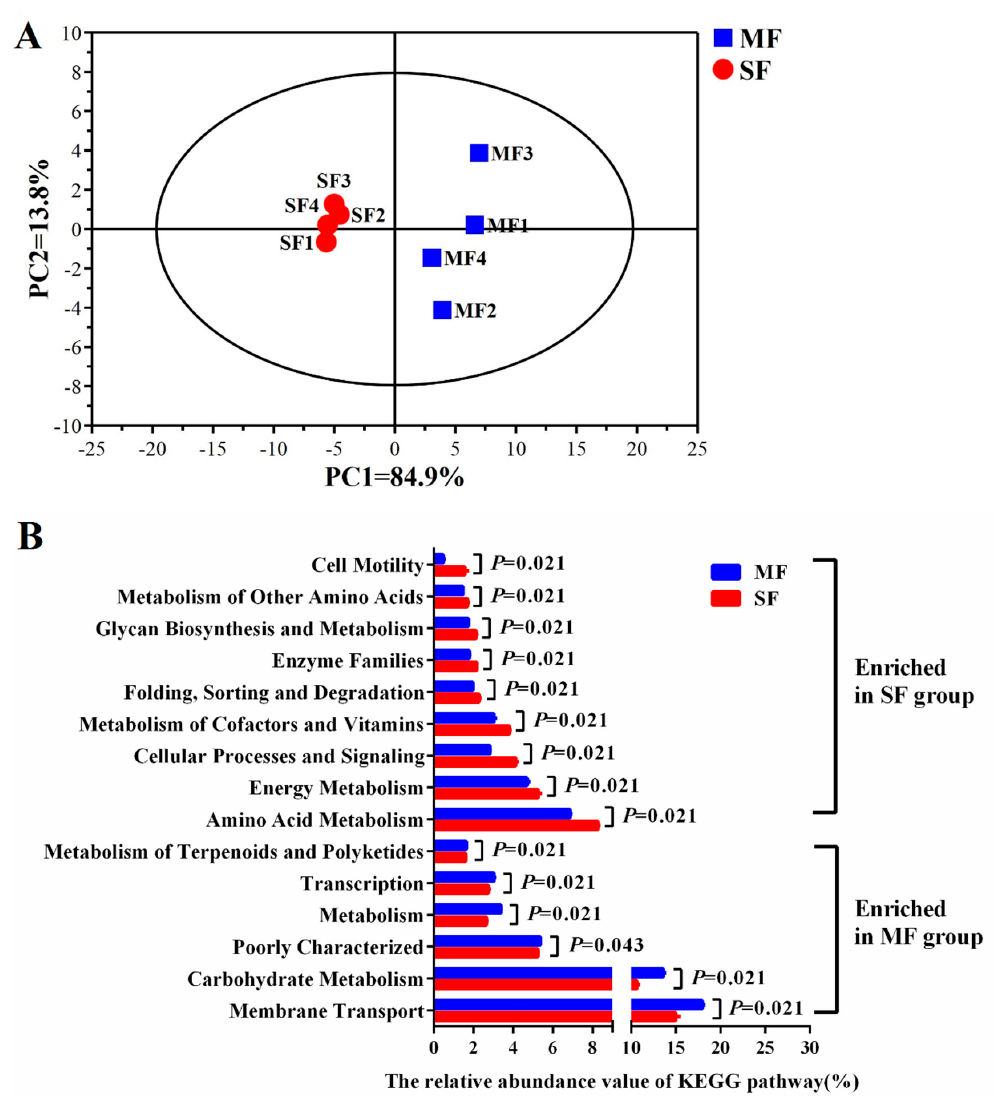
Figure 4. Functional predictions of microbes in fermented feed samples. ( A ) The principal component analysis (PCA) of gene pathways of microbes in fermented feed. ( B ) Effect of combined microbial fermentation on the abundance of Kyoto Encyclopedia of Genes and Genomes (KEGG) pathways (relative abundance > 1% and P < 0.05).